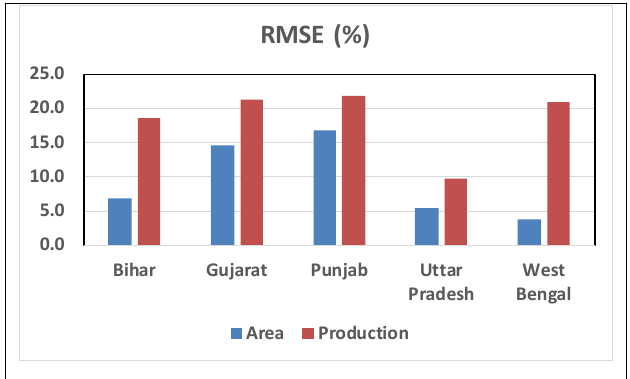
Figure 8. Comparison (RMSE) of state level estimates of potato crop with government estimates, for different